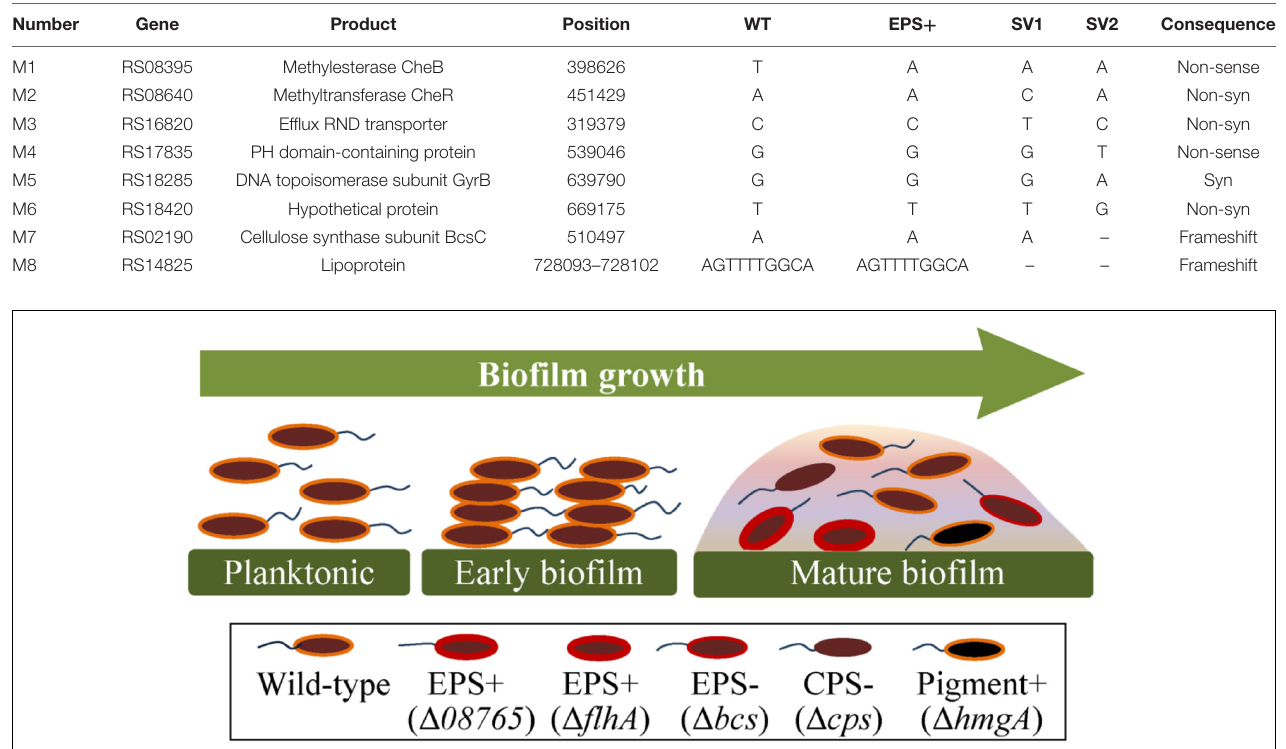
FIGURE 6 | Summary of the genetic and phenotypic variations in P. lipolytica biofilms. During the growth of biofilms, the bacteria swim and follow an attachment to a supporting surface. The generated spatially heterogeneous microenvironment was supposed to help give rise to different types of genetic variants, such as EPS+ (increased polysaccharide production with reduced swimming motility), EPS– (reduced polysaccharide production), CPS– (reduced capsular polysaccharide production) and pigment production variants (increased pyomelanin